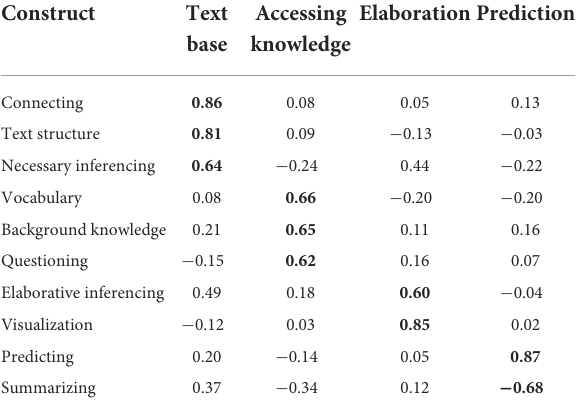
TABLE 4 Factors analysis components for the predictor